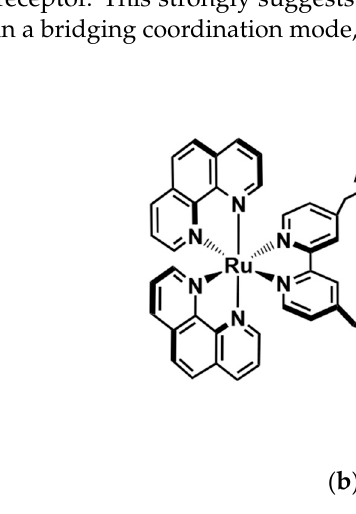
Figure 4. ( a ) Distribution diagrams of the complexes formed by the [Ru(phen) 2 L ] 2+ (the [Ru(phen) 2 L ] group is indicated with C for clarity) with Zn II and BPA 1:2:1 molar ratio ([Ru(phen) 2 L ] 2+ = 1.10 − 3 M); ( b ) proposed structure of the BPA adduct with the dizinc complex.